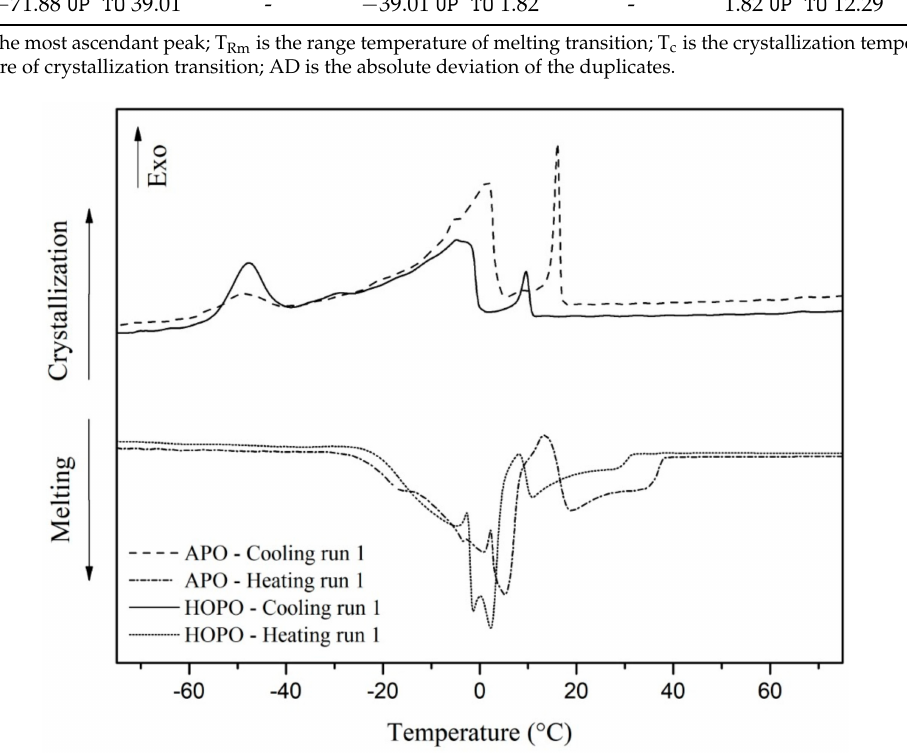
Figure 1. DSC curves in a heating and cooling program of APO and HOPO for run